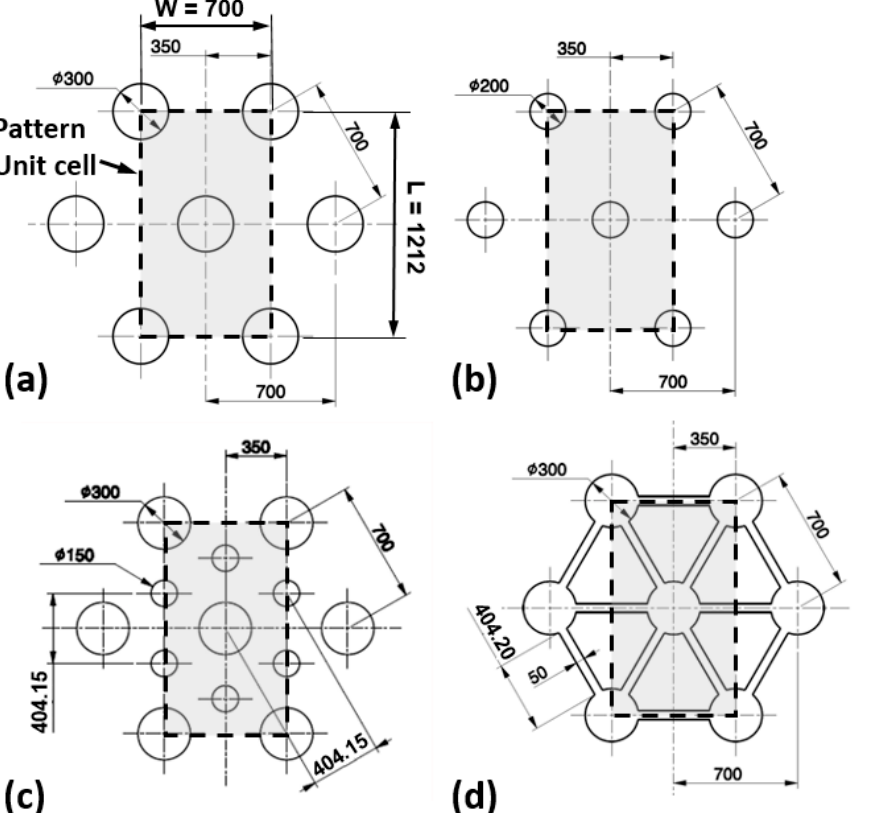
Figure 4. Micro-textures design. ( a ) HEX300; ( b ) HEX200; ( c ) HEX300-150; ( d ) HEX300 with channels ( μ m).